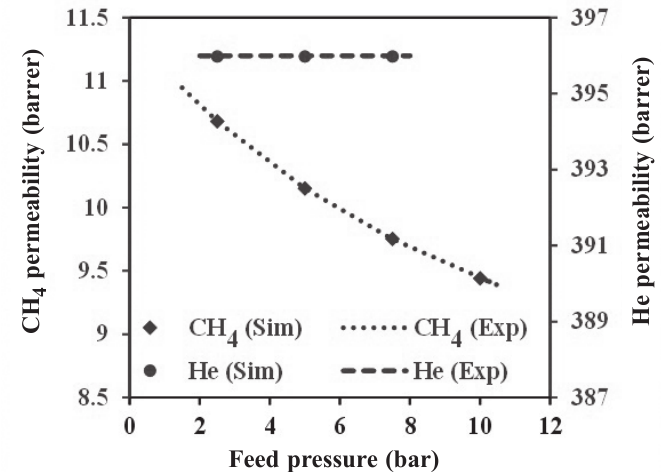
Fig. 4 – Validation of simulation data to experimental data (CH